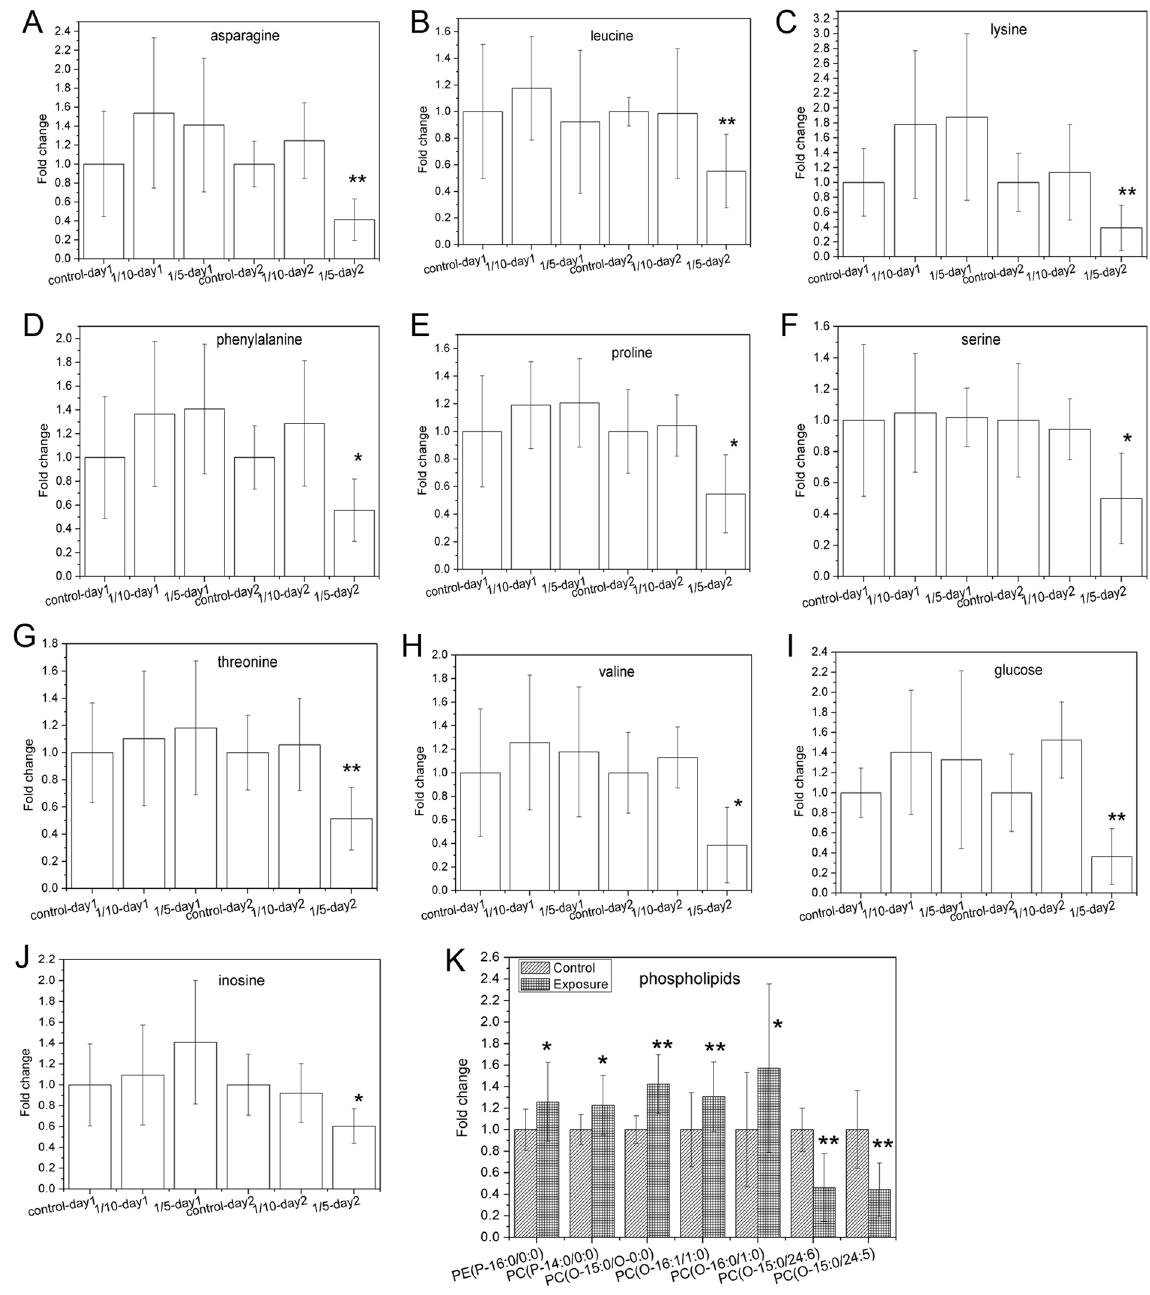
Figure 4. Fold changes of differentiated metabolites after acute TPHP expousre: ( A ) asparagine, ( B ) leucine, ( C ) lysine, ( D ) phenylalanine, ( E ) proline, ( F ) serine, ( G ) threonine, ( H ) valine, ( I ) glucoside, ( J ) inosine and ( K ) phospholipids. For A-J, fold changes were calculated by dividing the peak areas of the exposure groups with the mean peak area of the control group for the same day from the GC-MS chromatograms. For phospholipids, control group, “Control” refers to control-day 1 and day 2 samples, whereas “Exposure” refers to the pool of the rest of the samples, and fold changes were calculated by dividing peak area in “Exposure” with mean peak area in “Control”. Data are shown as mean ± standard deviation. Significantly different levels compared with related control are labeled with an asterisk (at P < 0.05) or two asterisks (at P < 0.01) based on a two-tailed student t